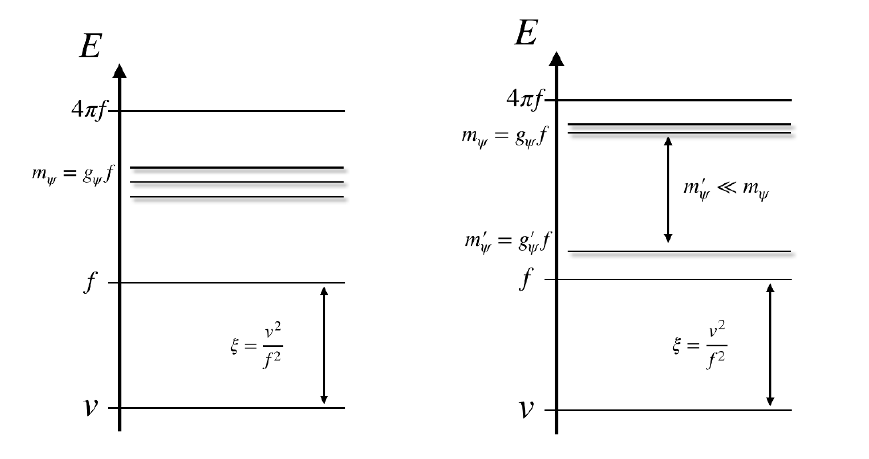
Figure 2 . The mass spectrum for composite states. All the composite states are normally expected at the mass scale m (left panel), or there are large mass splittings between di(cid:11)erent composite states (right panel). Compared to the case that all the masses are almost at m , we (cid:12)nd the impact of Higgs nonlinearity can be enlarged with the mass spectrum as shown in the right